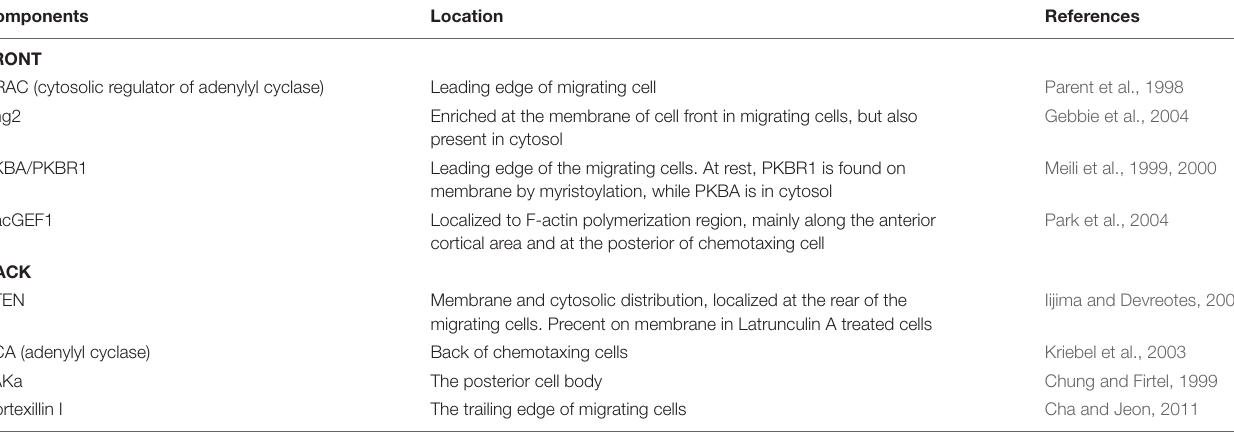
TABLE 1 | Examples of endogenous proteins which can serve as fluorescent biomarkers of the cell front and back due to their well-characterized localization.